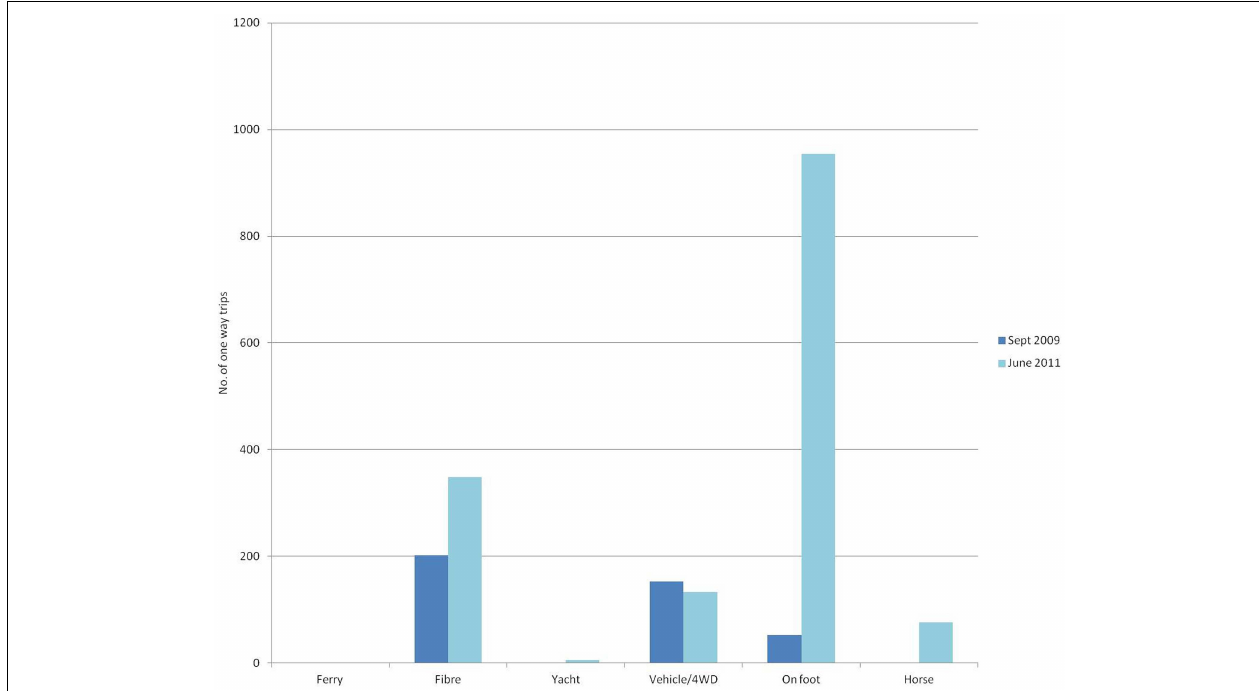
FIGURE 5 | Number of one-way trips made (in 1 month) by Solodamu villagers within Kadavu.